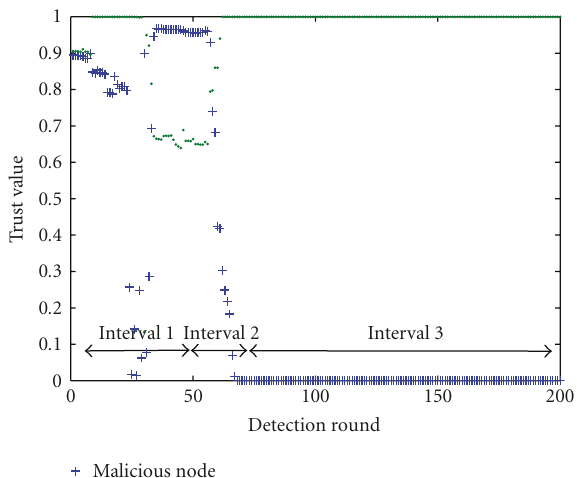
Figure 12: Dynamic suspicious level in proposed scheme (two malicious nodes perform FA attack during time